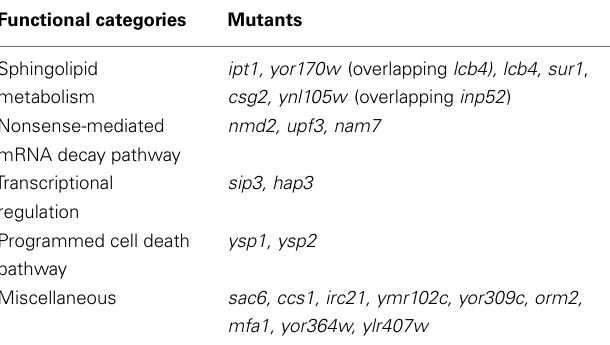
Table 1 | Genome-wide screen of S. cerevisae collection of haploid deletion mutants for amiodarone-tolerant